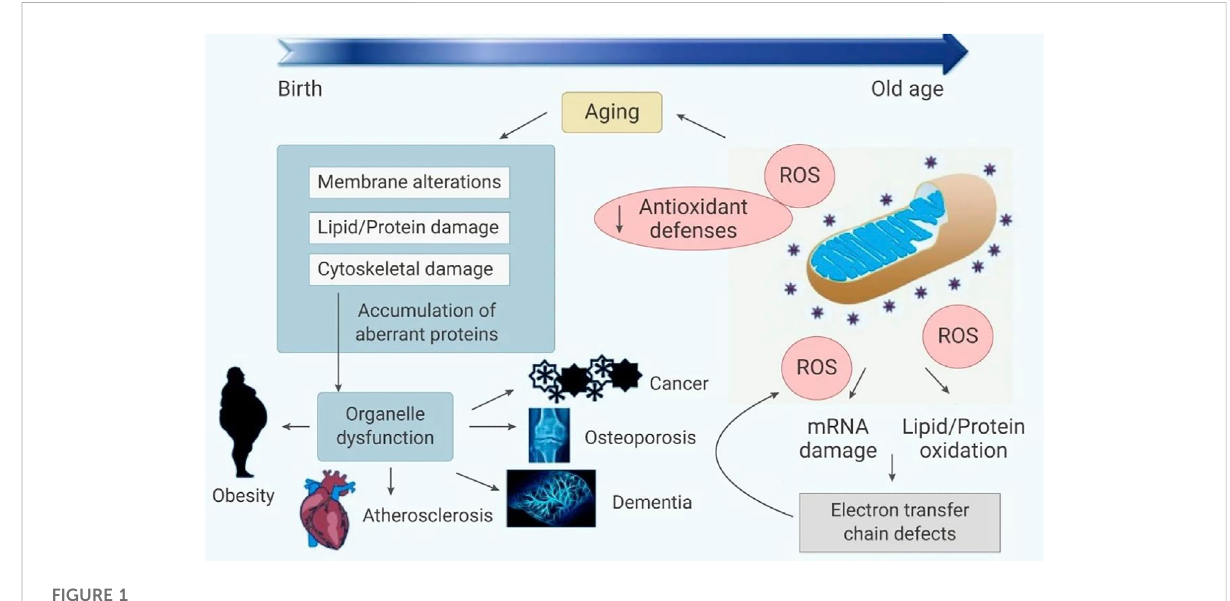
FIGURE 1 The relationship between oxidative stress and disease.